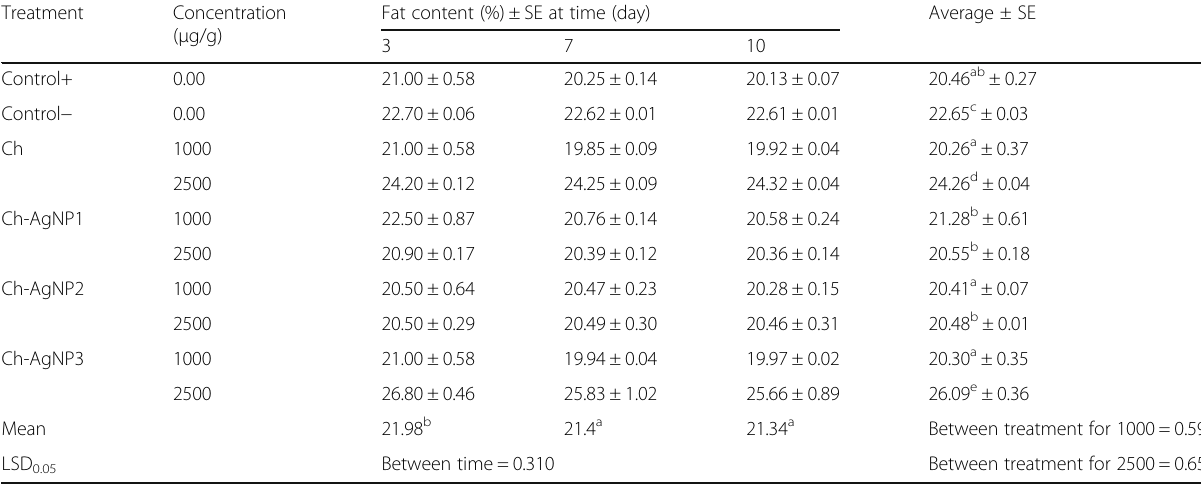
Table 4 Fat content (%) in minced beef meat products treated with chitosan (Ch) and chitosan-silver nanoparticles (Ch-AgNPs) after storage for 10 days at 4 °C